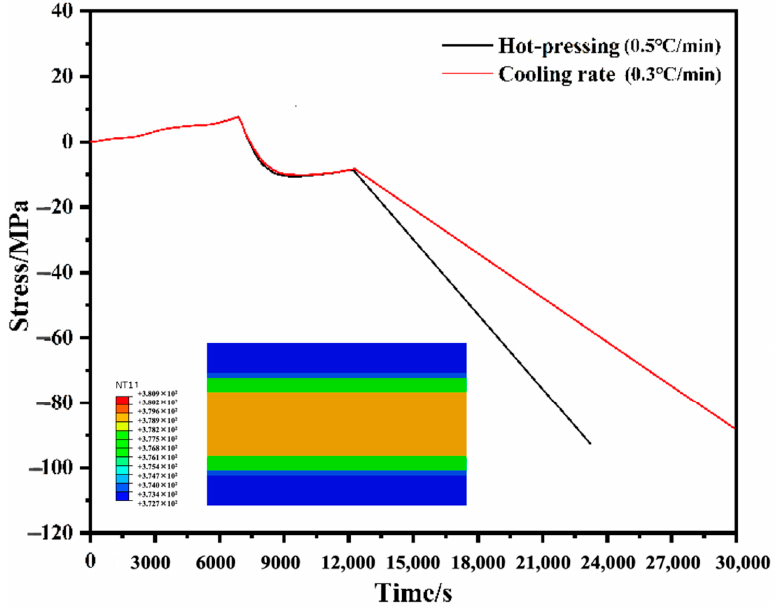
Figure 12. Comparison of stress evolution in the GFRP layer at the cooling rate of 0.5, 0.3 ◦ C/min, cooling rate of 0.3 ◦ C/min at the timing t = 18,000